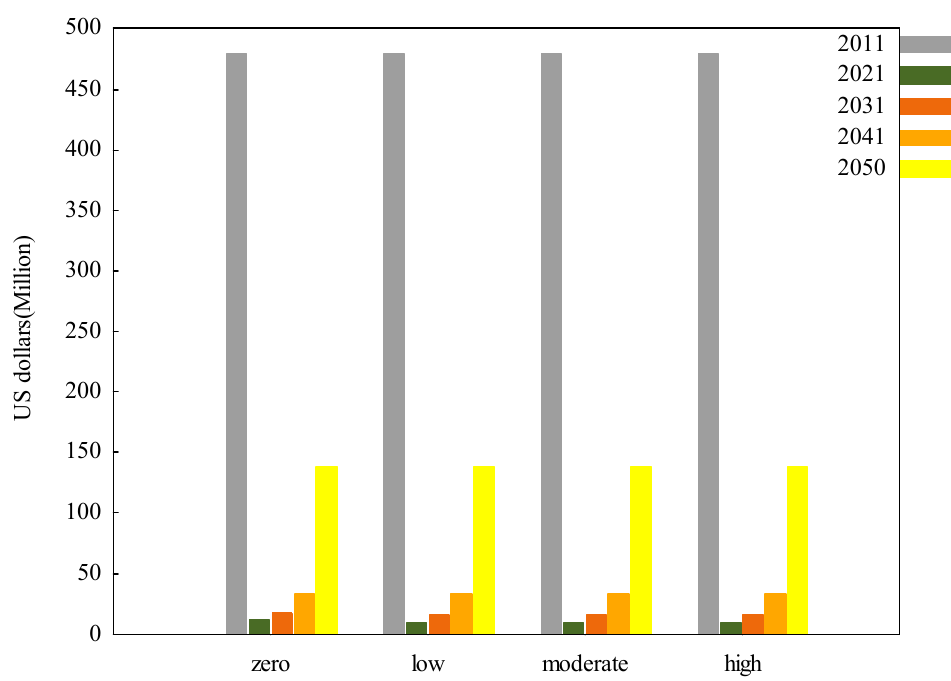
Figure 15. Total social welfare under no subsidy action.